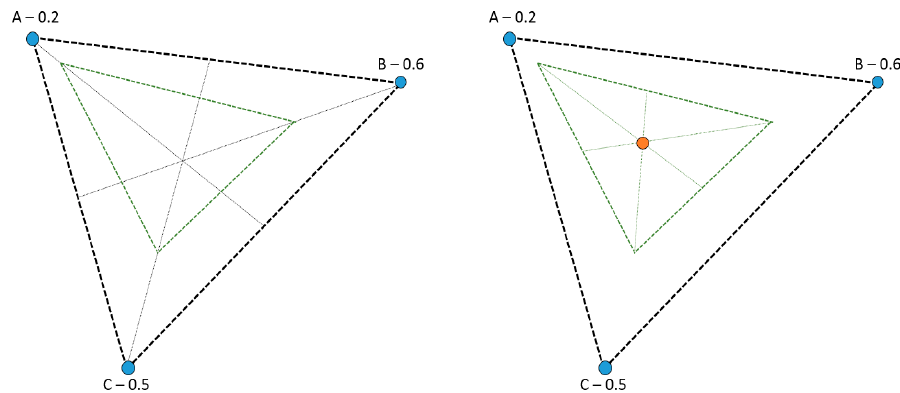
Figure 14. Weighted symmetric point between points A, B, and C.